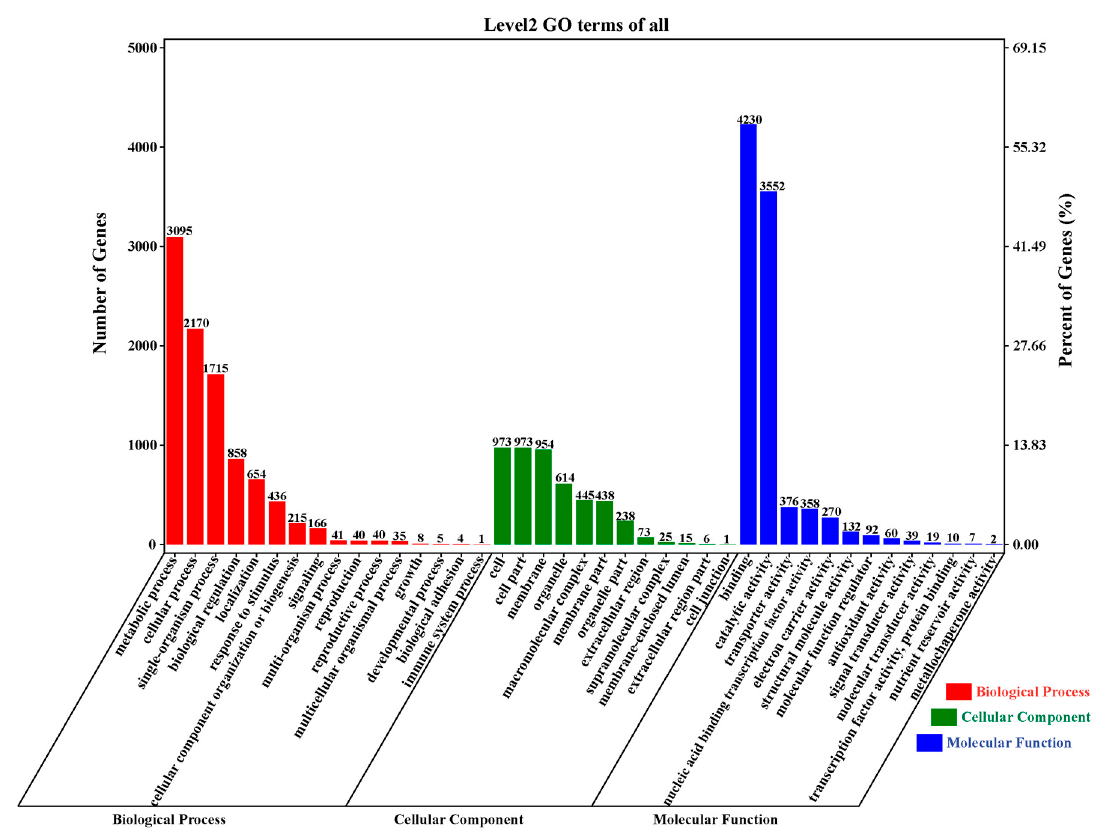
Figure 4. Gene ontology (GO) annotation distribution for differentially expressed genes in G. anomalum under drought stress. Histograms represent the functional distribution; the left y ‐ axis shows the number of genes, and the right y ‐ axis shows a percentage of the number of genes.